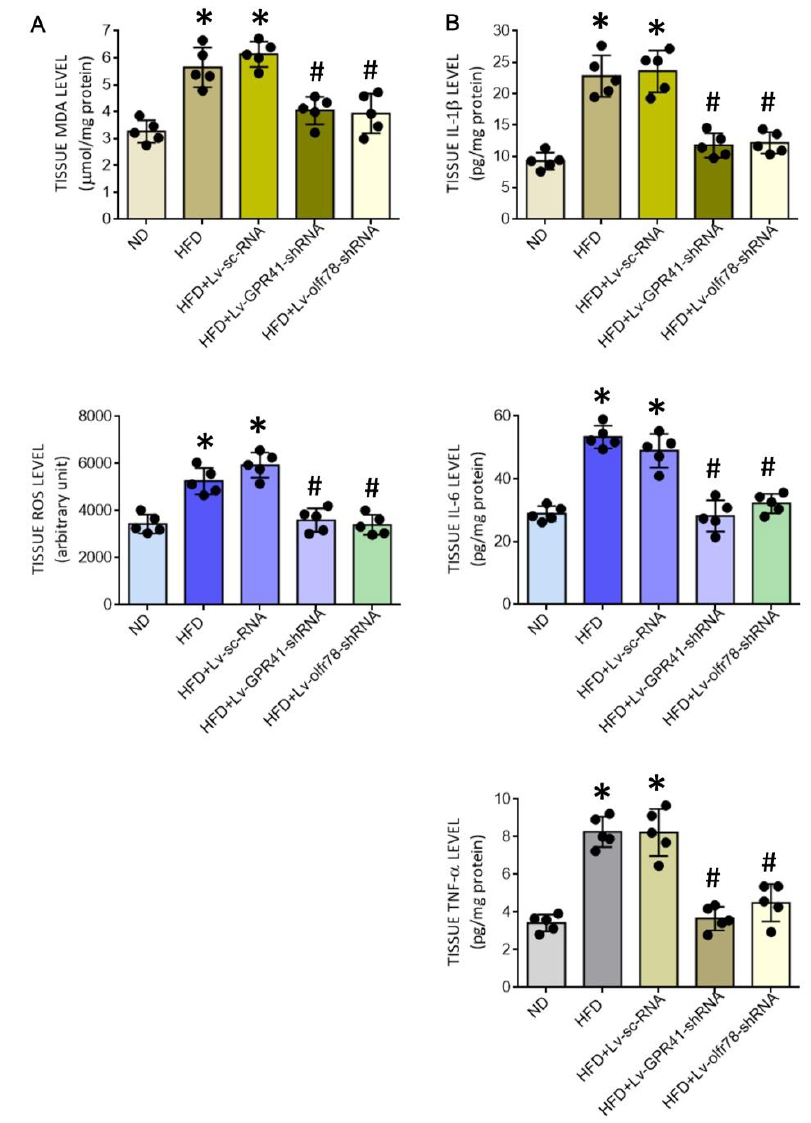
Figure 7. Tissue MDA and ROS levels ( A ) and levels of proinflammatory cytokines IL-1 β , IL-6, and TNF- α ( B ) in the PVN of adult ND or HFD offspring, alone or with microinjection bilaterally into the PVN of HFD offspring of Lv-GPR41-shRNA (1 × 10 5 IFU), Lv-olfr78-shRNA (1 × 10 5 IFU) or Lv-sc-RNA control, performed at the age of 8 weeks. Data are presented as mean ± SD, n = 5 in each group. * p < 0.05 vs. ND group, and # p < 0.05 vs. HFD group in the post hoc Tukey’s multiple-range test.